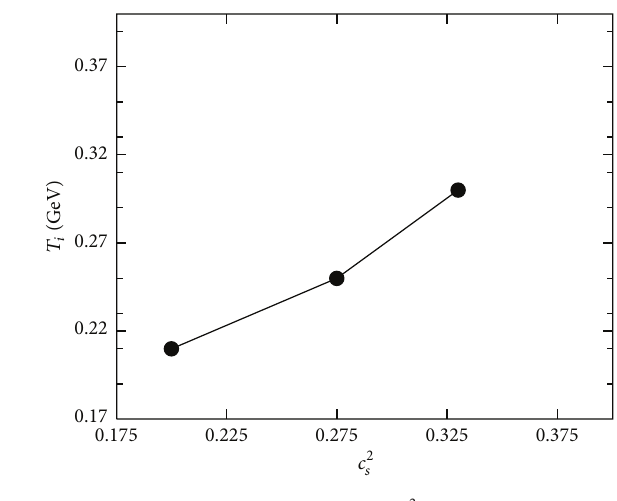
Figure 10: The variation of 𝑇 𝑖 with 𝑐 2 𝑠 for fixed 𝑑𝑁/𝑑𝑦 .